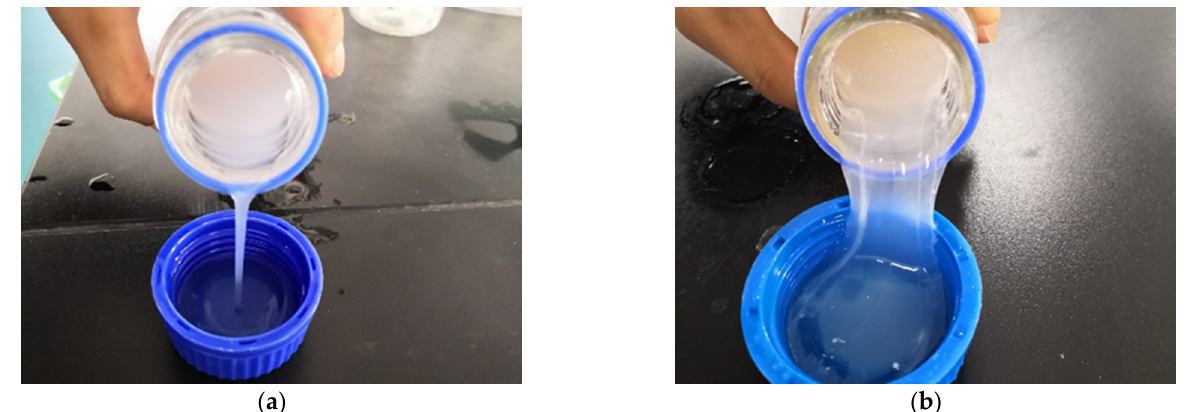
Figure 4. The newly configured gel system ( a ) and the gel system after gelation ( b